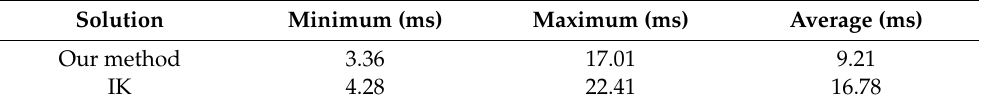
Table 6. Performance evaluation in a multi-user